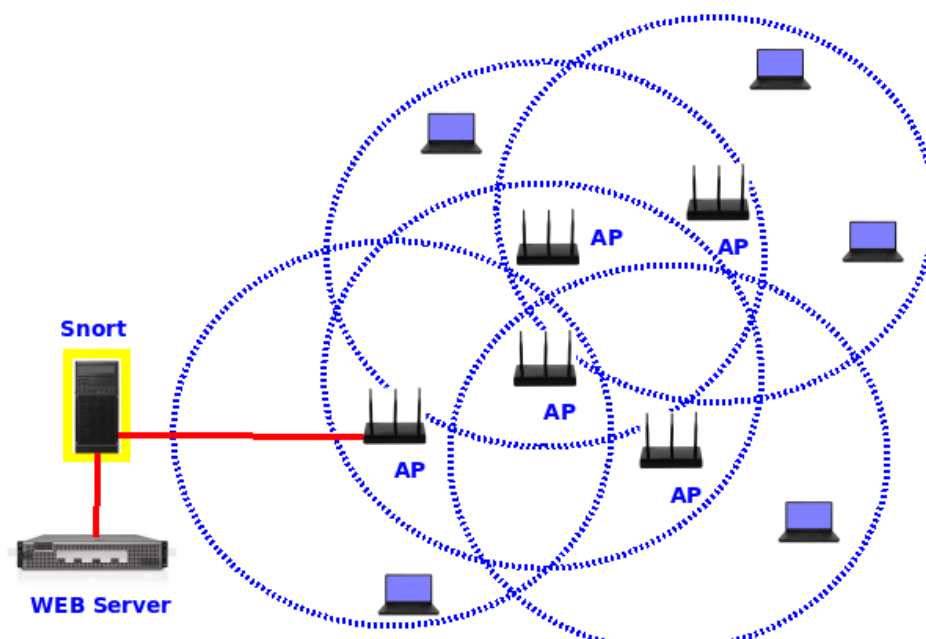
Figure 10. Experimental scenario using